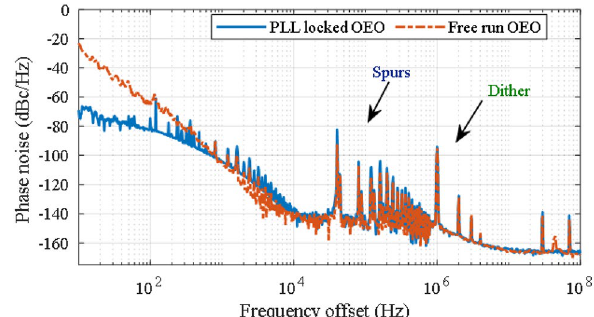
Figure 8. Measured phase noise of the free OEO and phase locked OEO. 100 correlation is used for the